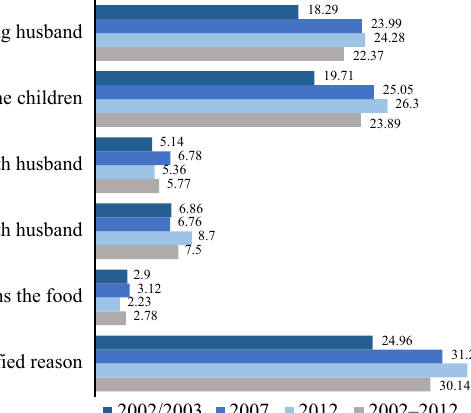
Figure 1. Women ’ s acceptance of domestic physical violence